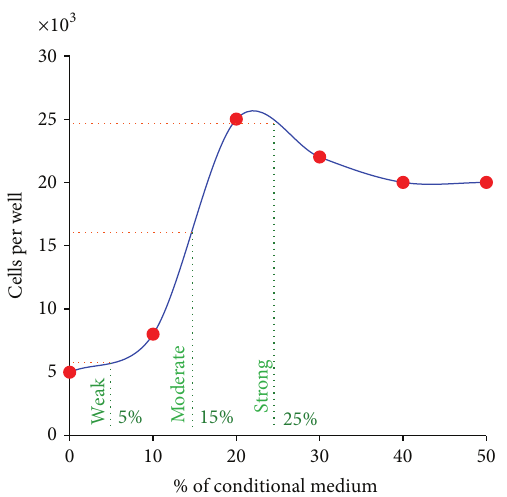
Figure 2: Dose determination of tumor-conditioned medium used to prepare HMEC with tumor-induced cell surface profiles. HMEC cultures were incubated with 0, 10, 20, 30, 40, or 50% tumor- conditioned medium. After 3 days in culture, cells were counted (red points) in wells using trypan blue exclusion. Cell numbers were approximated using a curve used to determine the concentrations of tumor-conditioned medium that elicited either weak (stimuli just a little higher than in the control), moderate (half of the maximum), or strong (maximum) stimulation of HMEC cultures (green lines). Green lines represent percentage selected for b